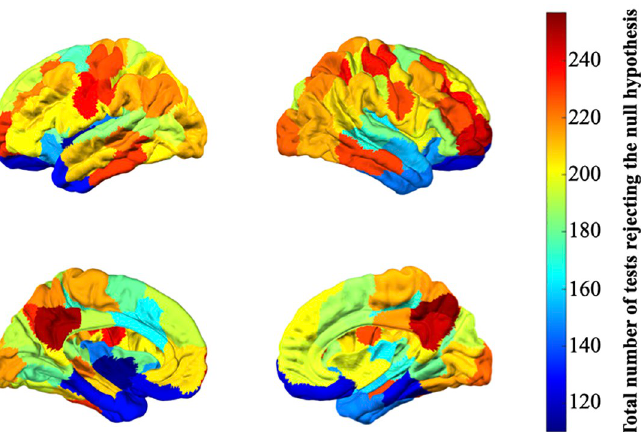
Fig 6. Number of statistically distinguishable power spectrum ( p < 0.05) in each ROI plotted on the brain overlays.